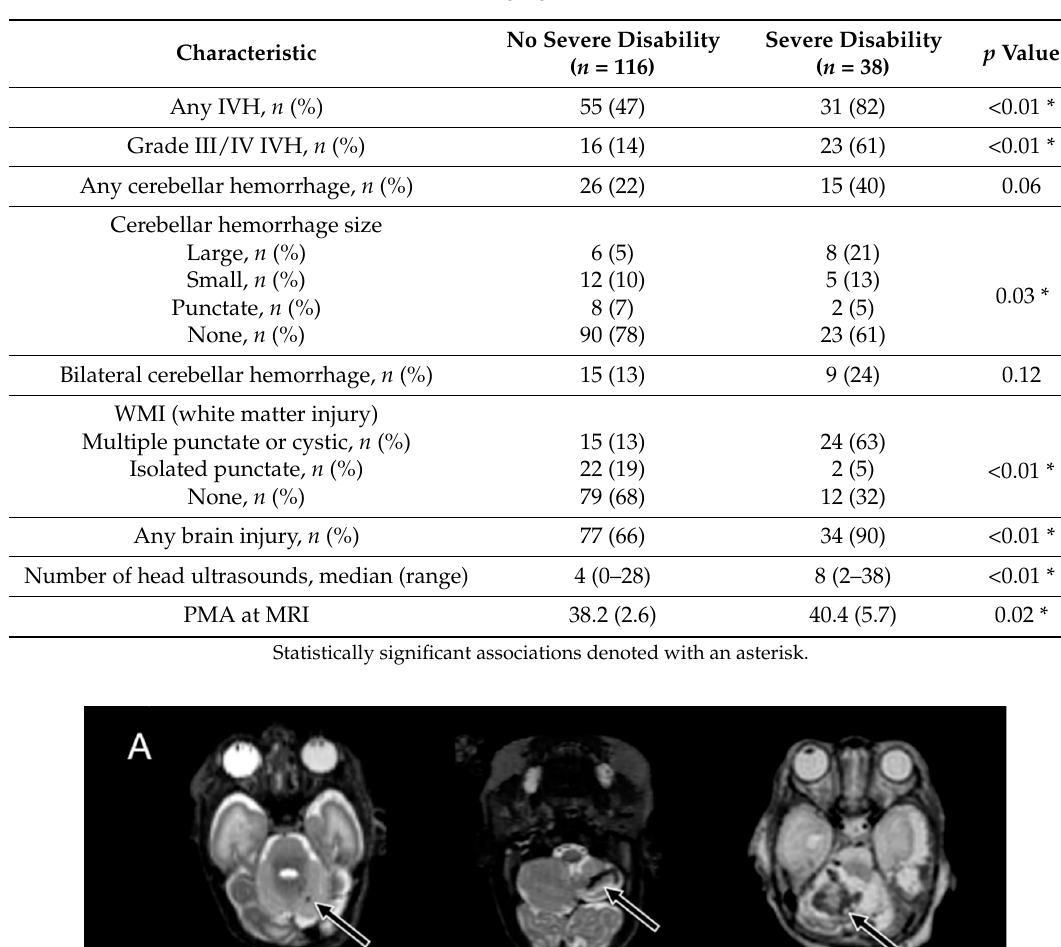
Table 3. Imaging Characteristics.